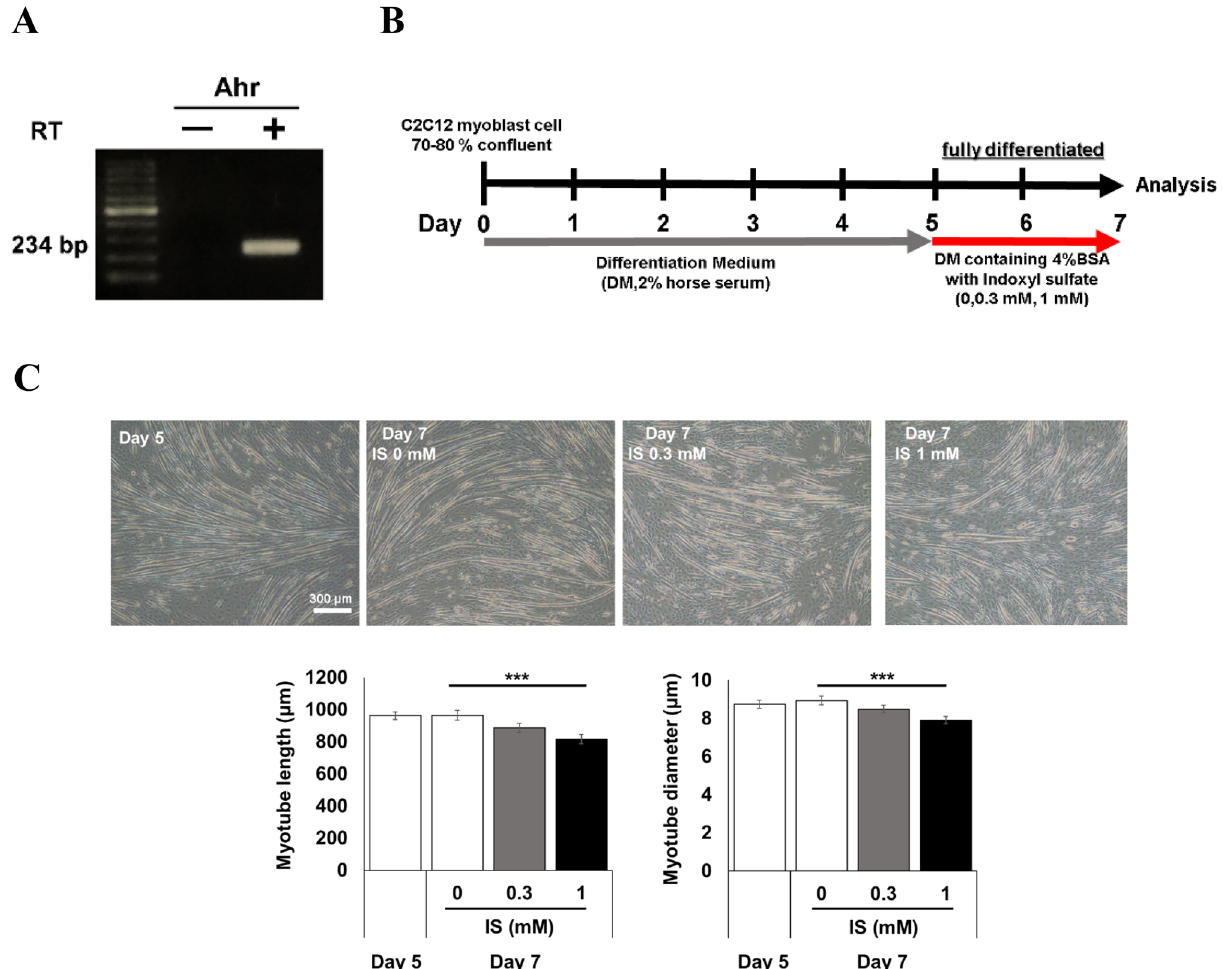
Figure 5. Ahr receptor was detected in C2C12 myotubes and IS administration caused cell size reduction in fully differentiated C2C12 myotubes. ( A ) Expression of Ahr was confirmed with electropheresis for PCR products of mouse C2C12 myotube cDNA. PCR products without reverse transcriptase (RT) was loaded as a negative control. ( B ) Differentiated C2C12 myotubes were stimulated with indoxyl sulfate (IS) together with BSA as IS binds to albumin with a high affinity in vivo. ( C ) Representative micrographs of C2C12 myotubes stimulated with IS at 0 mM, 0.3 mM and 1 mM for 2 days were shown (top). The scale bar is 300 μm. Myotube morphology was quantitatively evaluated in terms of the length (lower left) and the diameter (lower right). N = 100 and 200 myotubes per group, respectively. Error bars indicate SEM. *** p <